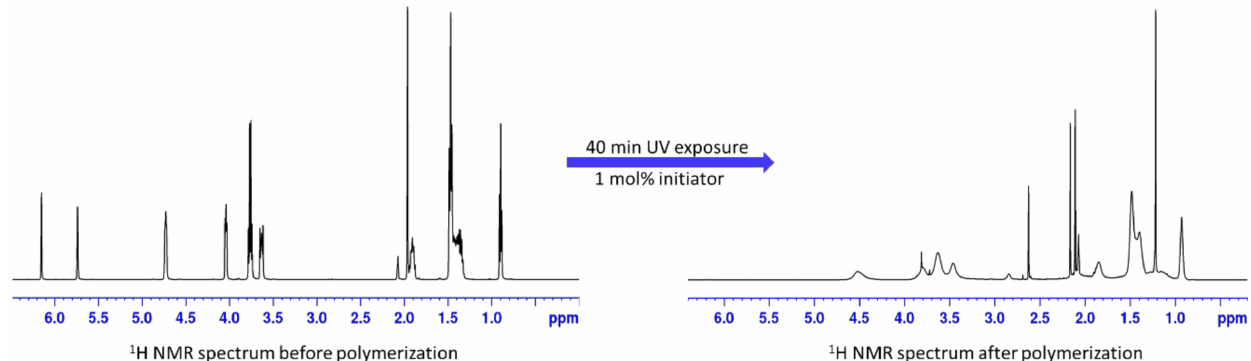
Figure 2. 1 H NMR spectrum of [C 2 N MA,22 ]TFSI before and after polymerization. Samples were dissolved in acetone-d 6